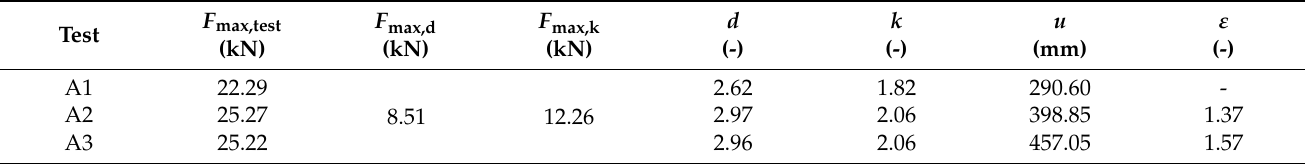
Table 5. Results of experiment A, using bolts and